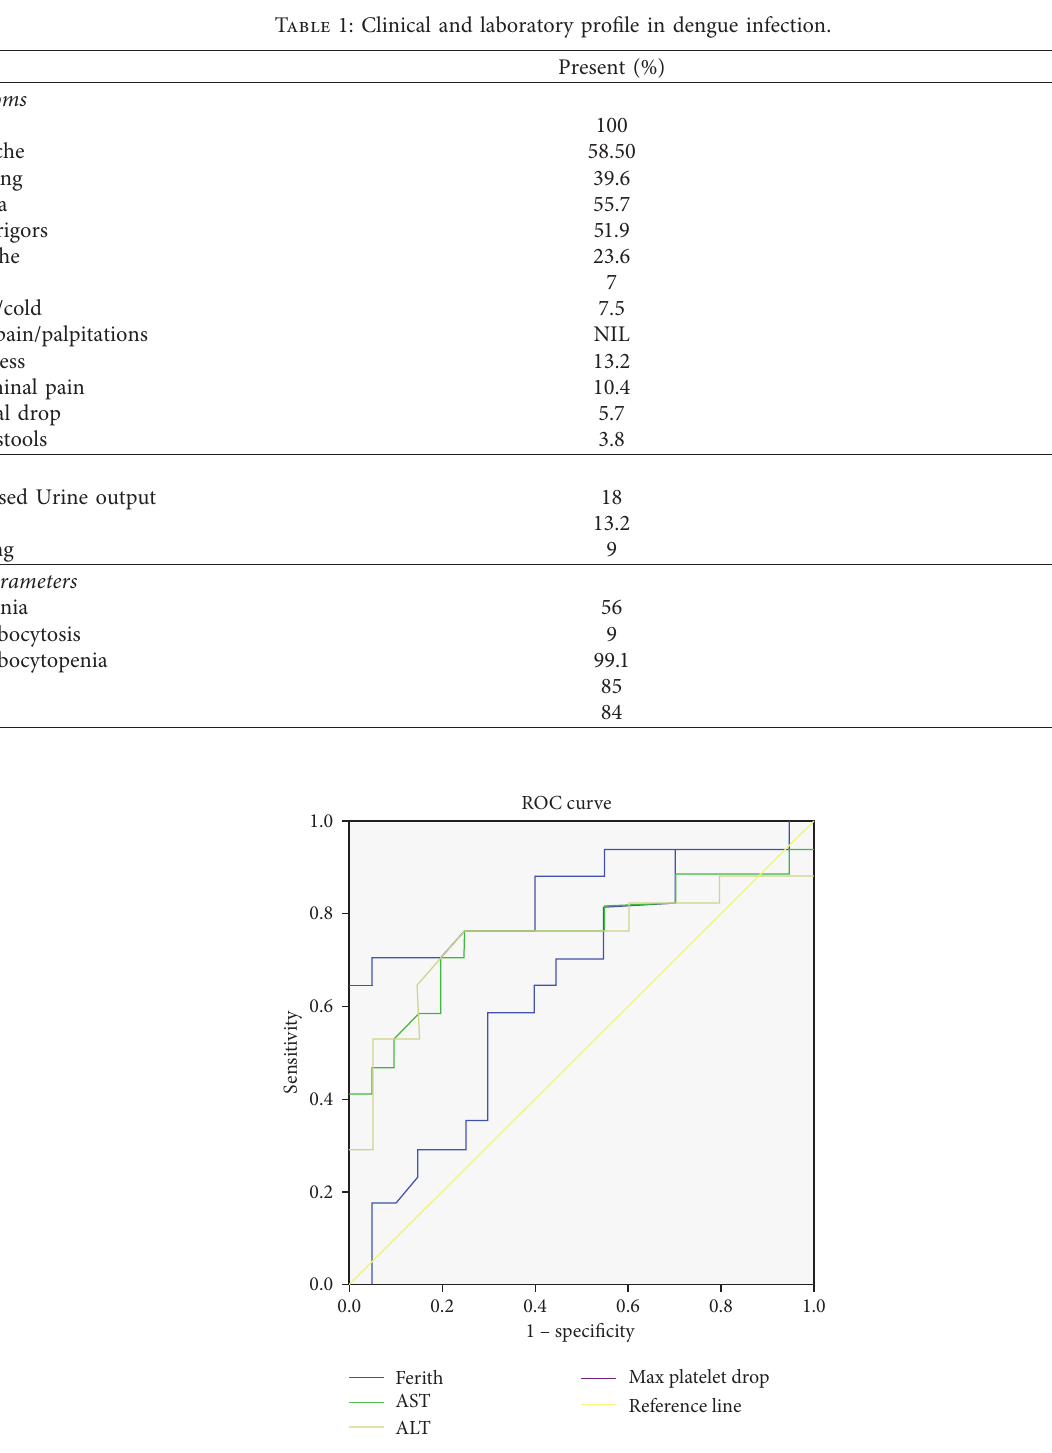
Figure 3: ROC curve for various biomarkers as predictors of dengue